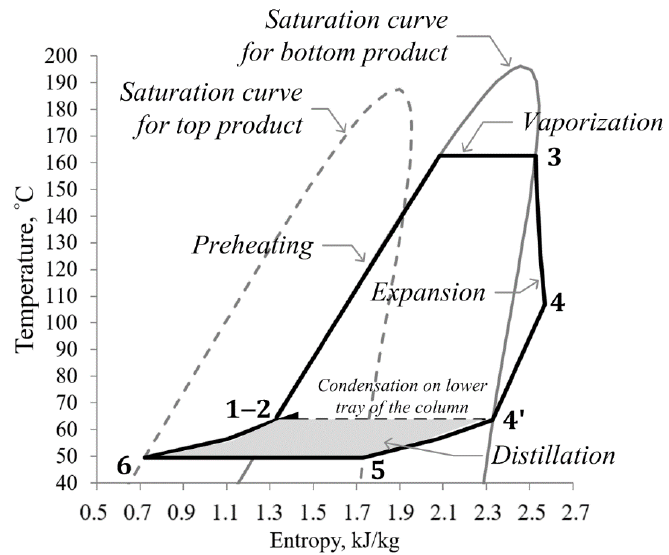
Figure 6. T-S diagram for iso-pentane/n-pentane distillation integrated with a turboexpander.